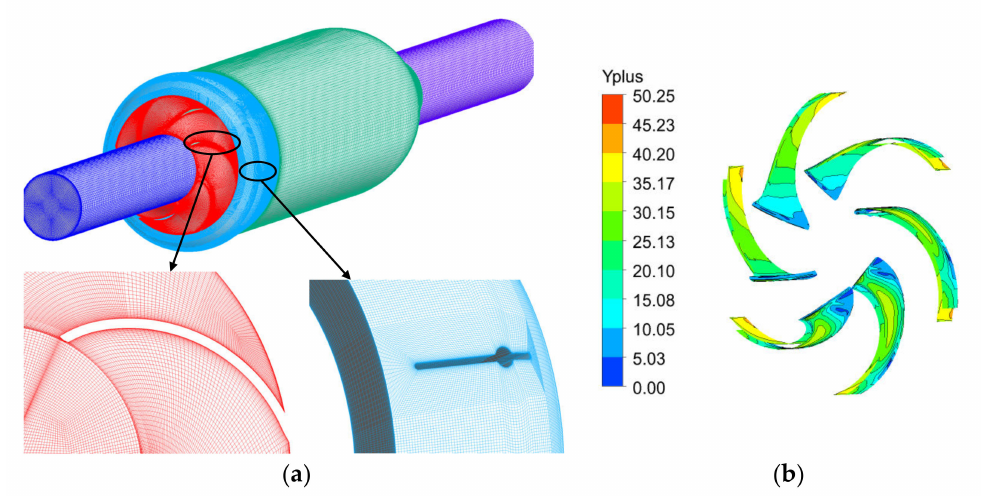
Figure 2. Results of grid division. ( a ) Mesh detail. ( b ) y + distribution.